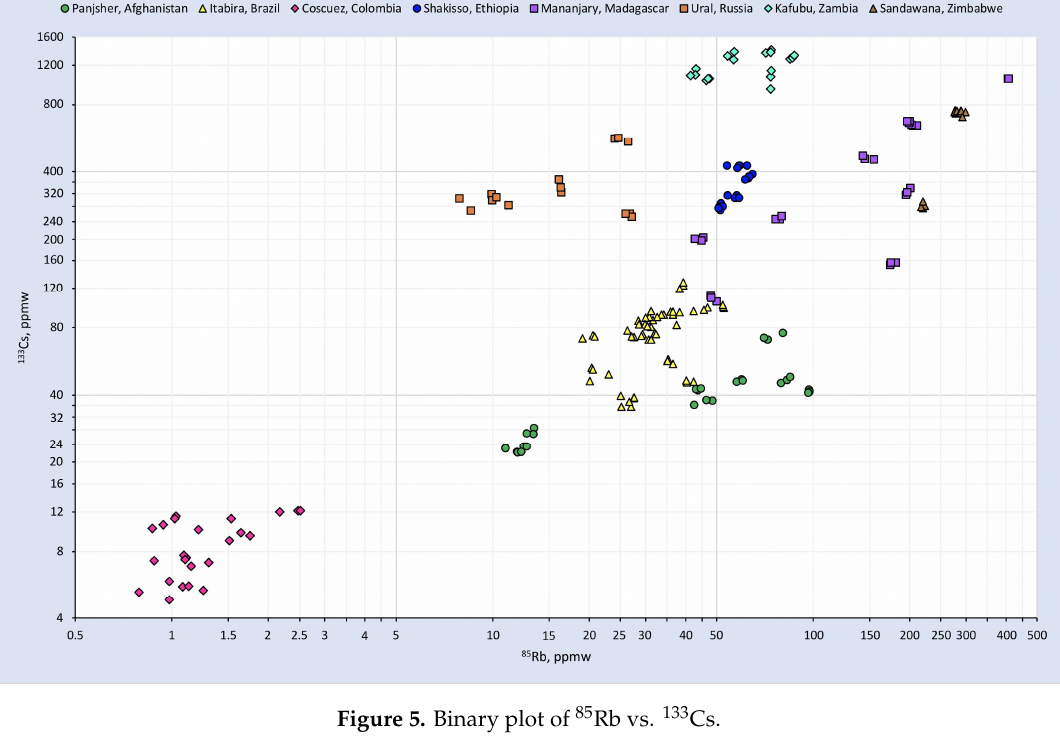
Figure 5. Binary plot of 85 Rb vs. 133 Cs.